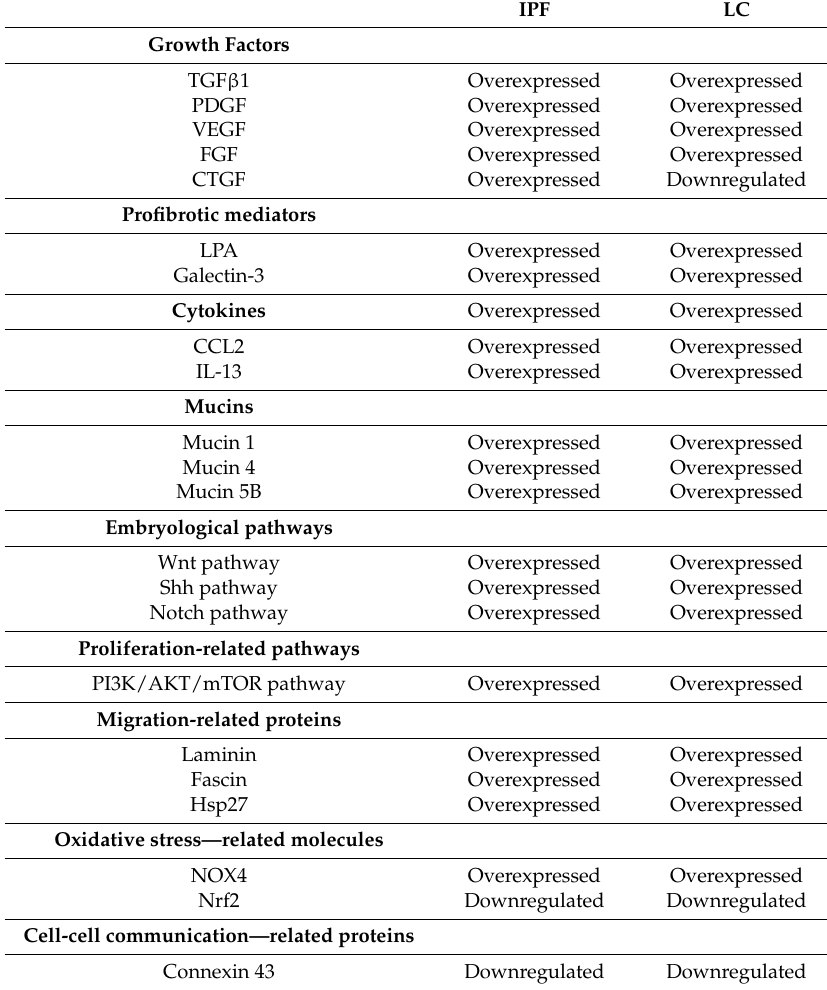
Table 3. Principal fibrogenic molecules and signal transduction pathways participating in lung cancer (LC) and idiopathic pulmonary fibrosis